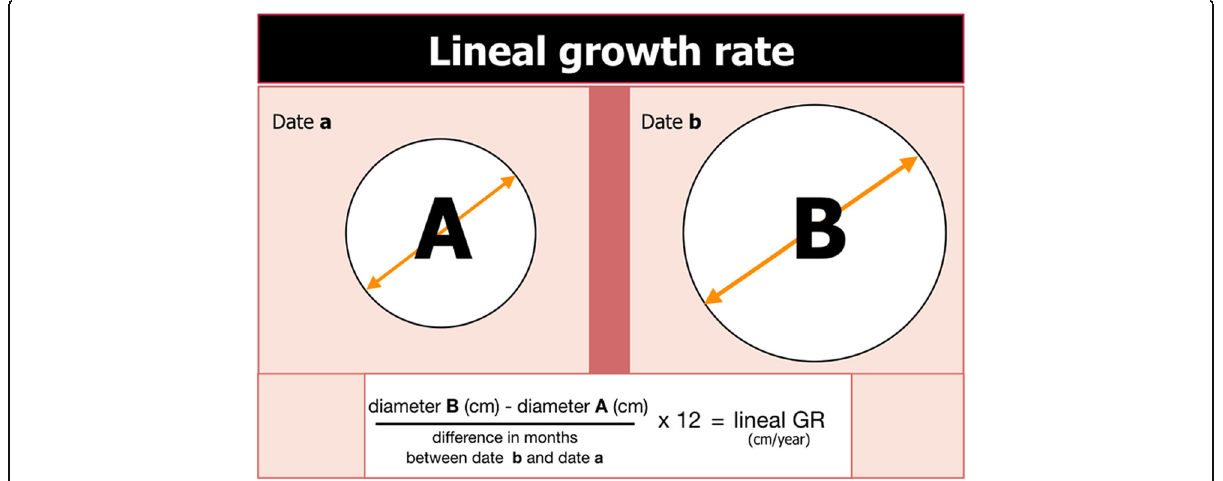
Fig. 9 Formula of linear growth rate (GR) per year. To define the linear GR per year, divide the difference between the maximum tumor diameter (MTD) into two time points by the difference of the number of months between the two CT times and then multiply by